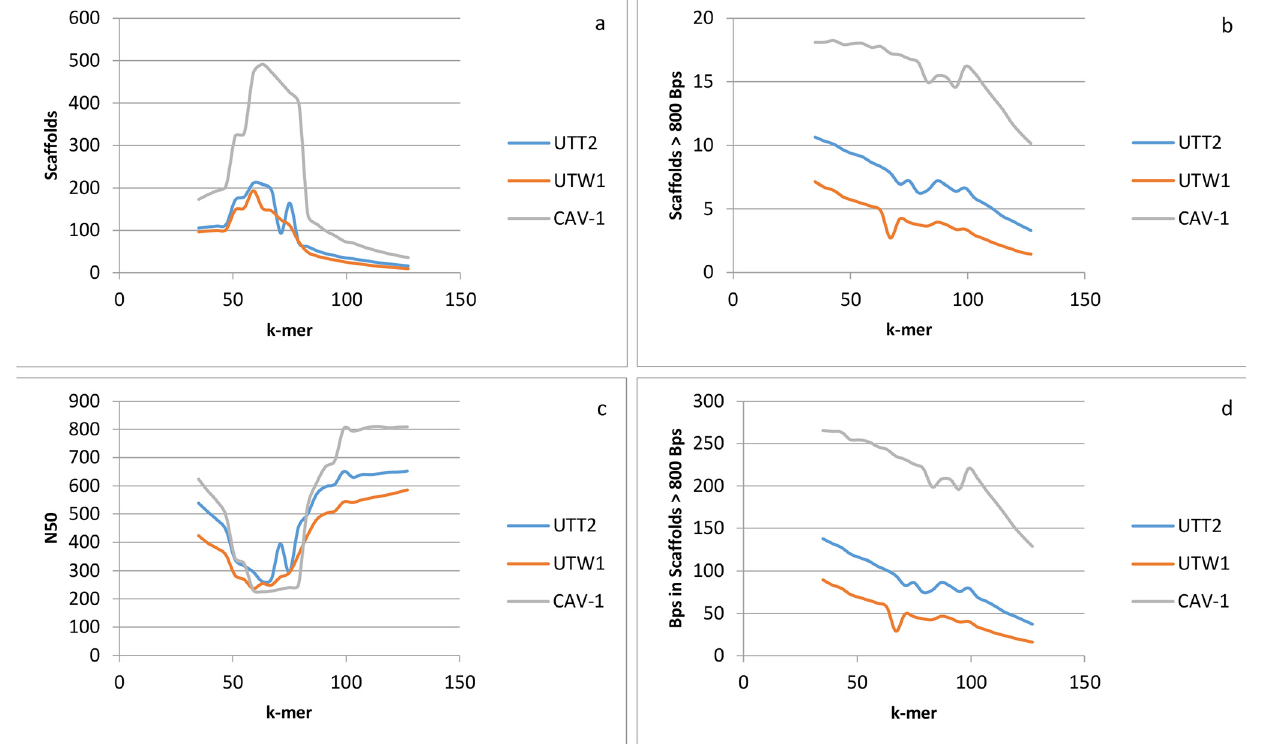
Fig 1. Assembly statistics based on variable k-mer lengths. Transcript assemblies based on variable k-mer lengths ranging from 35 – 127 in multiples of four of A . tridentata tridentata (UTT2), A . tridentata wyomingensis (UTW1) and A . arbuscula (CAV-1). a) Thousands of scaffolds vs. k-mer length. b) Thousands of scaffolds > 800 bp vs. k-mer length. Scaffolds are divided by 1000. c) N50 vs. k-mer length. d) Millions of scaffolds > 800 vs. k-mer length.